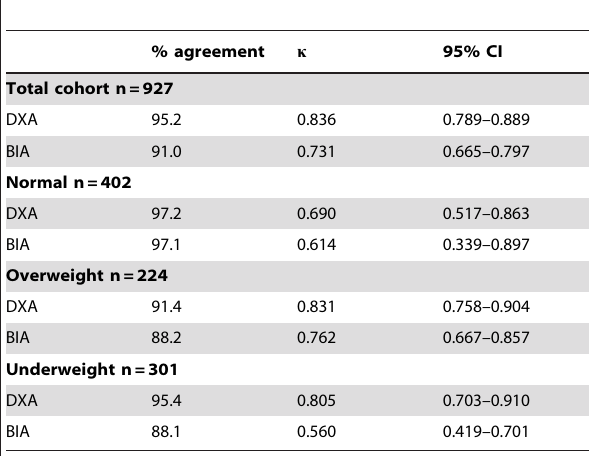
Table 4. Cross-tabulation statistics for evaluation of DXA and BIA against 4C